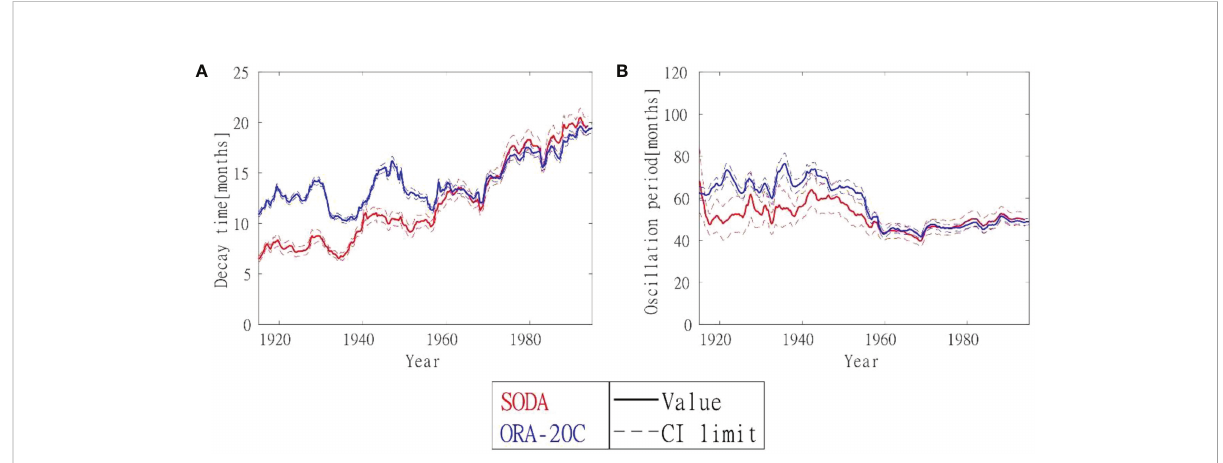
FIGURE 4 Decay times (A) and oscillation period (B) for the ReOsc+ model for ENSO (Eq. 7 fi tted as explained in Section 2.3) in the period 1900-2009 for SODA (red) and ORA-20C (blue) reanalysis. Each point of the fi gure considers a time window of 30 years, and the represented year in the horizontal axis is the mean value of that interval. Solid lines represent the value of the characteristic times, and dashed lines show the (1- standard-deviation) con fi dence intervals. (They were computed as described in Section 3 and Supplementary Appendix D, respectively).